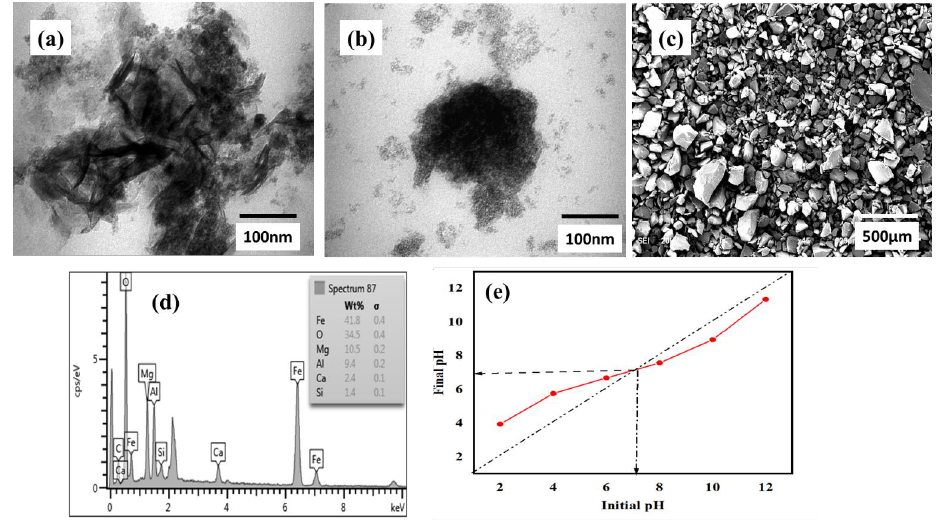
Figure 2. SBAC-MgAlFe: ( a ) TEM before phenol uptake, ( b ) TEM after phenol uptake, ( c ) SEM image, ( d ) EDS analyses, ( e ) Point of zero charge.